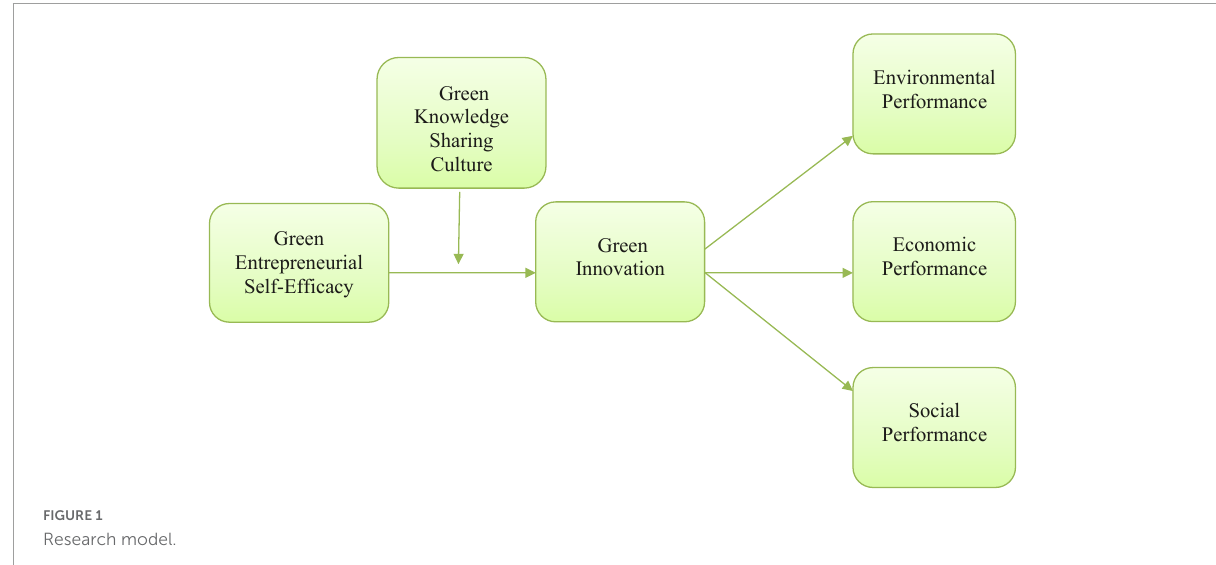
FIGURE1 Research